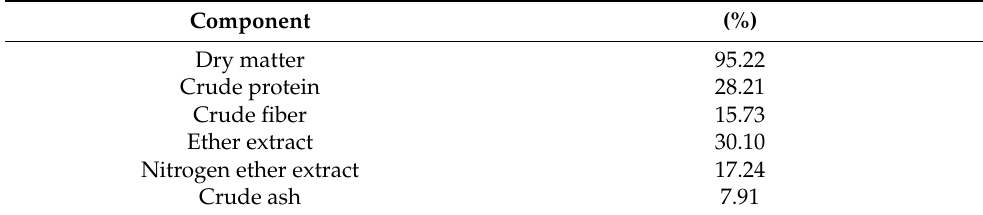
Table 2. Chemical composition of powdered rocket salad